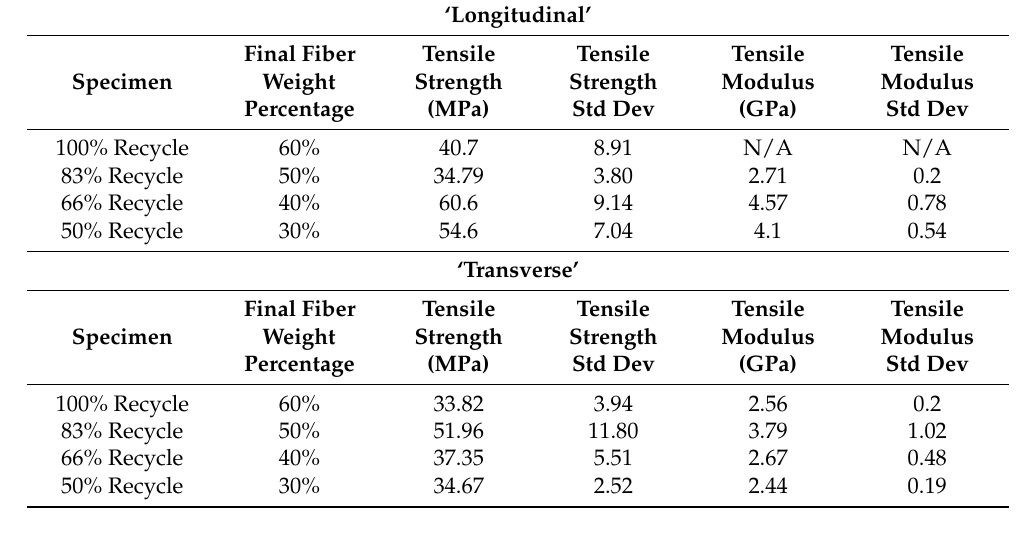
Table 3. Tensile strength and modulus for ‘Longitudinal’ and ‘Transverse’, respectively.